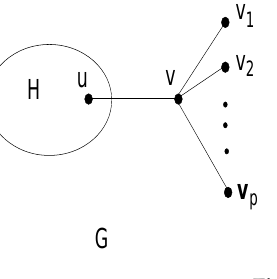
Figure 1. The σ -transform at v